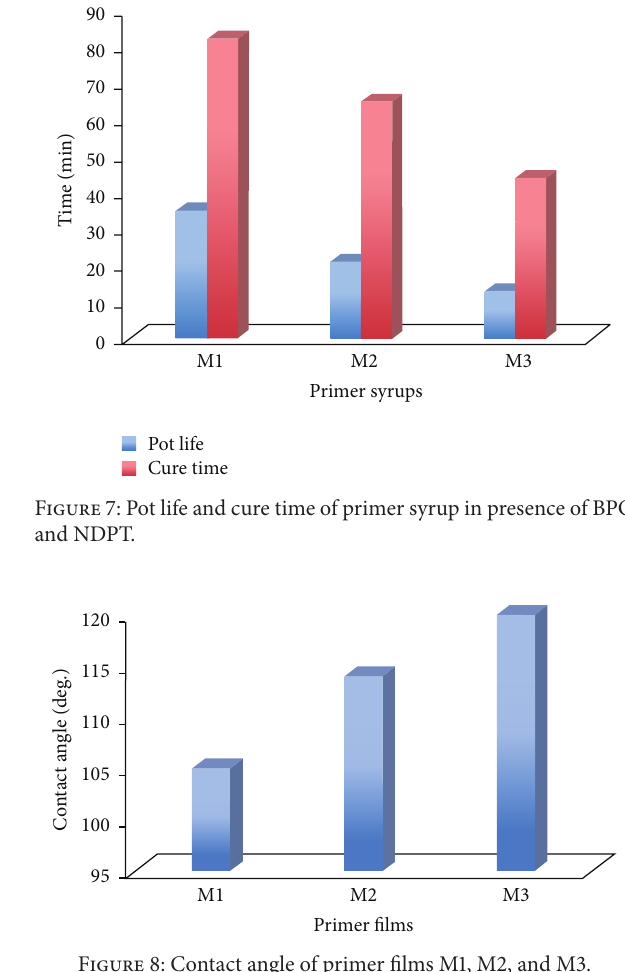
Figure 8: Contact angle of primer films M1, M2, and